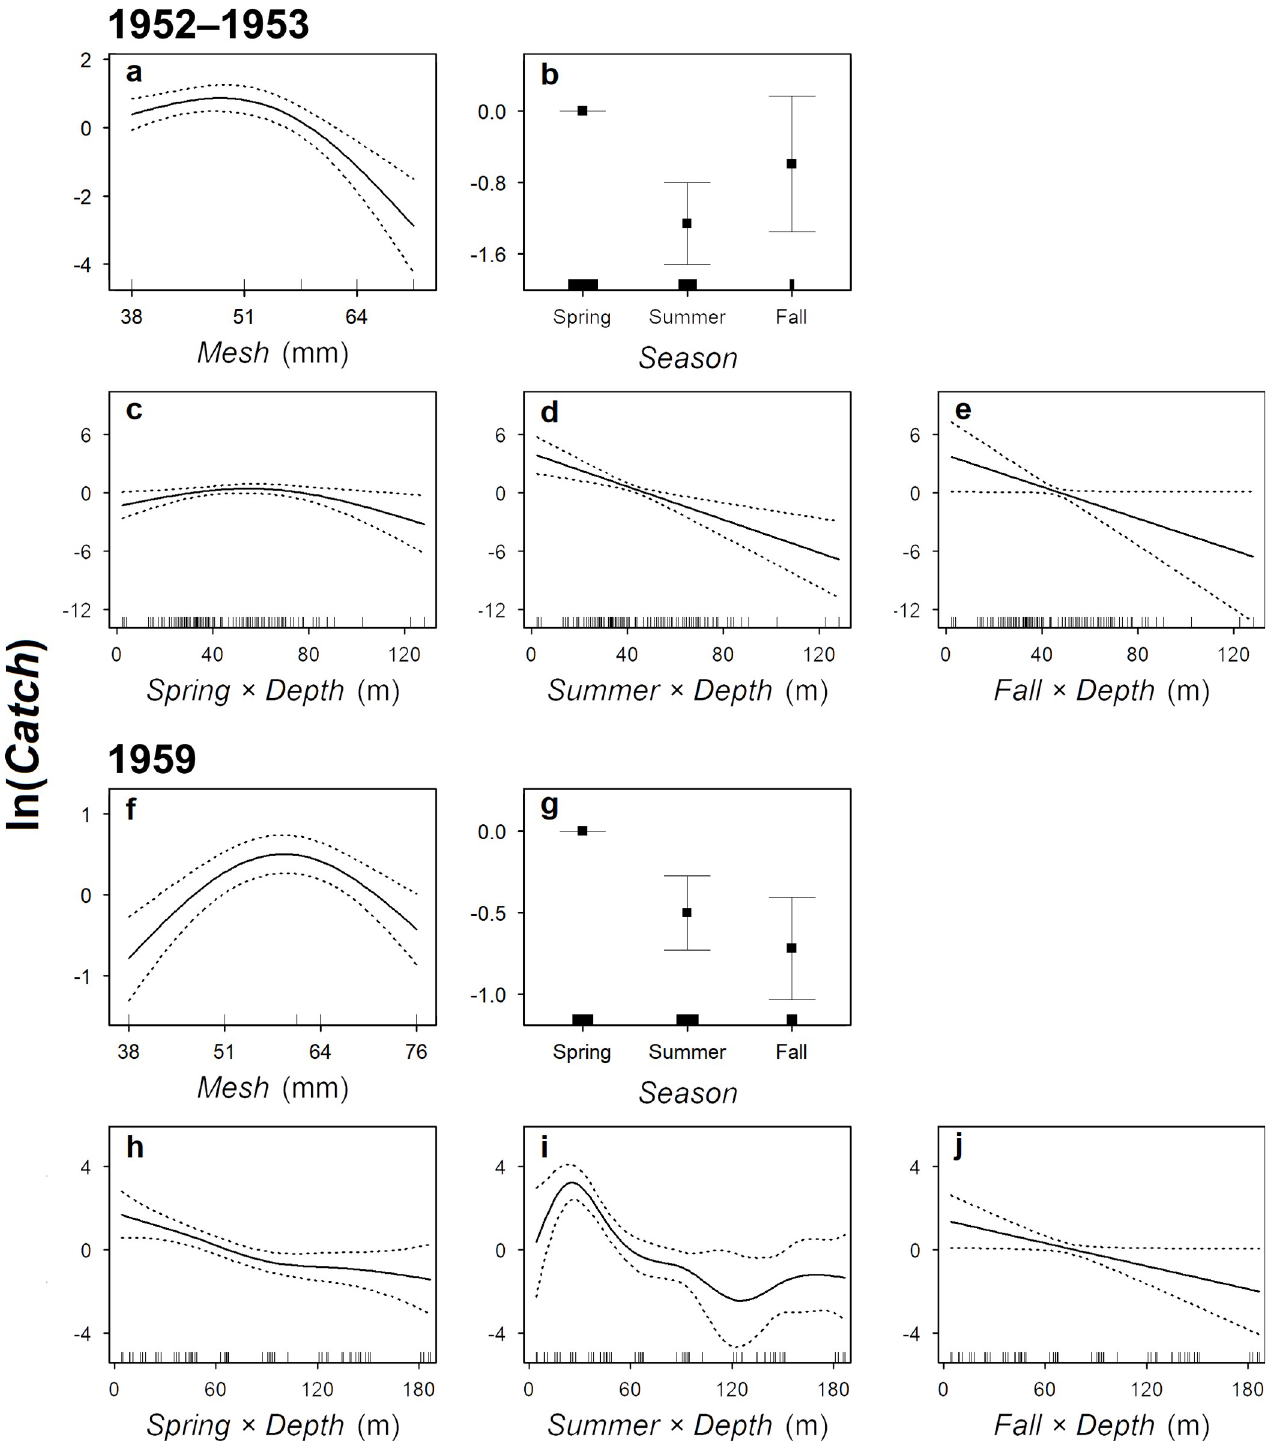
Fig 3. The relationships between predicted number of Cisco caught ( Catch ) and predictors in the selected generalized additive models fitted to gill-net data from Lake Superior. Mesh is a continuous variable representing gill-net mesh size (stretch). Season is a categorical variable representing spring, summer, and fall. Depth is a continuous variable representing bottom depth of which a smoothing function was fitted for each season. In panels for the smoothing functions (a, c–e, f, and h–j), solid lines represent the predicted values, dotted lines represent +/ − one standard error, and ticks above the horizontal axis represent the distribution of data points. In the panels for categorical variables (b and g), points represent the predicted values, error bars represent +/ − one